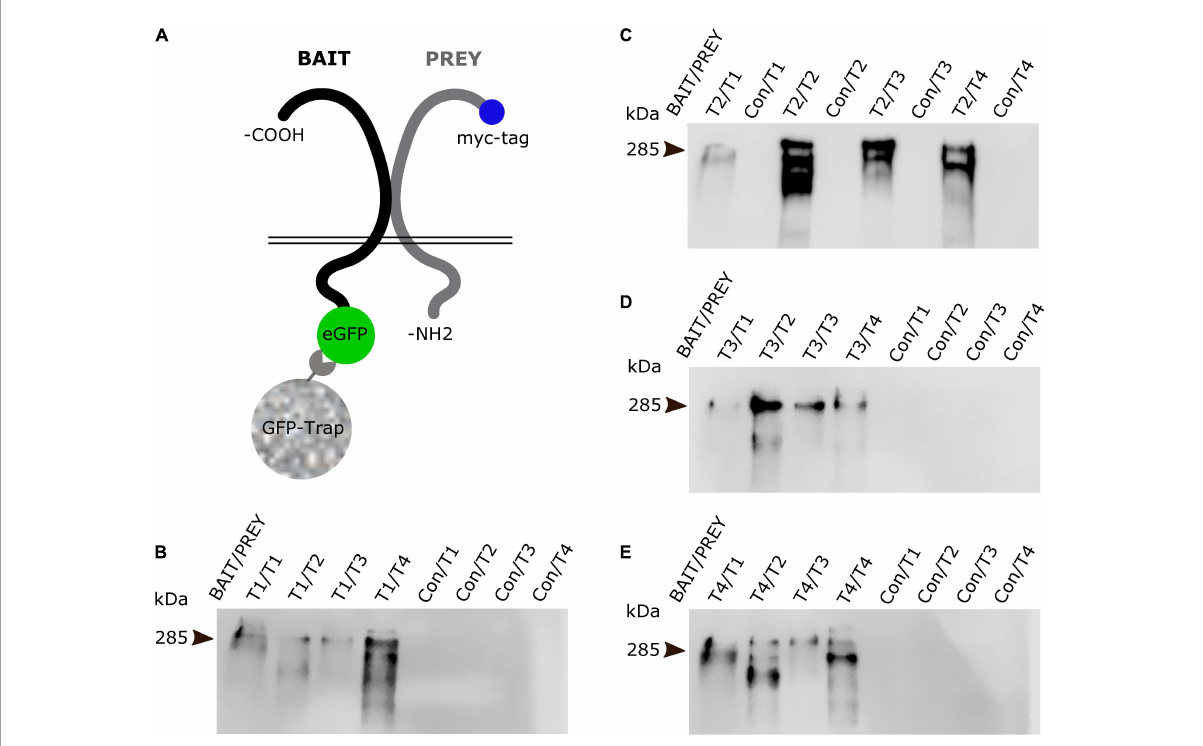
FIGURE5 All teneurin paralogues can form heterodimers in cis . (A) Co-immunoprecipitation strategy with EGFP-tagged teneurin bait construct after co-transfection with tagRFP-tagged prey constructs in N2a cells. EGFP only expressing construct was used as control bait. Blots were probed for myc-tag which is only present on the prey constructs. (B–E) Bait teneurin paralogues were able to interact and specifically pull down itself and all other paralogues. Representative anti-myc-tag (prey) blots from (B) Tenm1, (C) Tenm2, (D) Tenm3 and, (E) Tenm4 pulldowns reveal presence of prey protein only in lanes with teneurin bait (Bait/Prey) but not with control bait (Con/Prey).